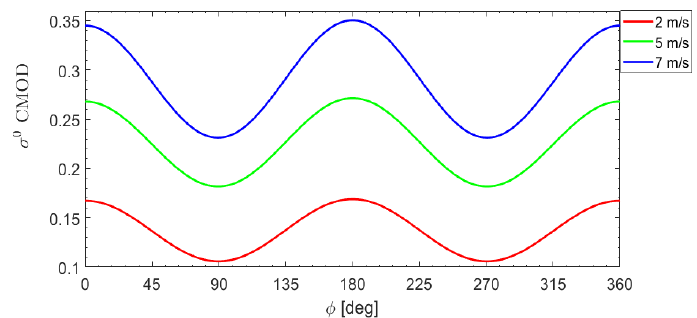
Figure 2. 𝜎 0 computed with CMOD-IFREMER, see equation (15), as a function of wind speed and Figure 2. σ 0 computed with CMOD-IFREMER, see Equation (15), as a function of wind speed and direction, for 23° of incidence angle. Results for three different wind speed values are shown: 7 m/s direction, for 23 ◦ of incidence angle. Results for three di ff erent wind speed values are shown: 7 m / s (blue line), 5 m/s (green line), 2 m/s (red line). 𝜙 = 0° indicates a wind blowing towards the antenna. (blue line), 5 m / s (green line), 2 m / s (red line). φ = 0 ◦ indicates a wind blowing towards the